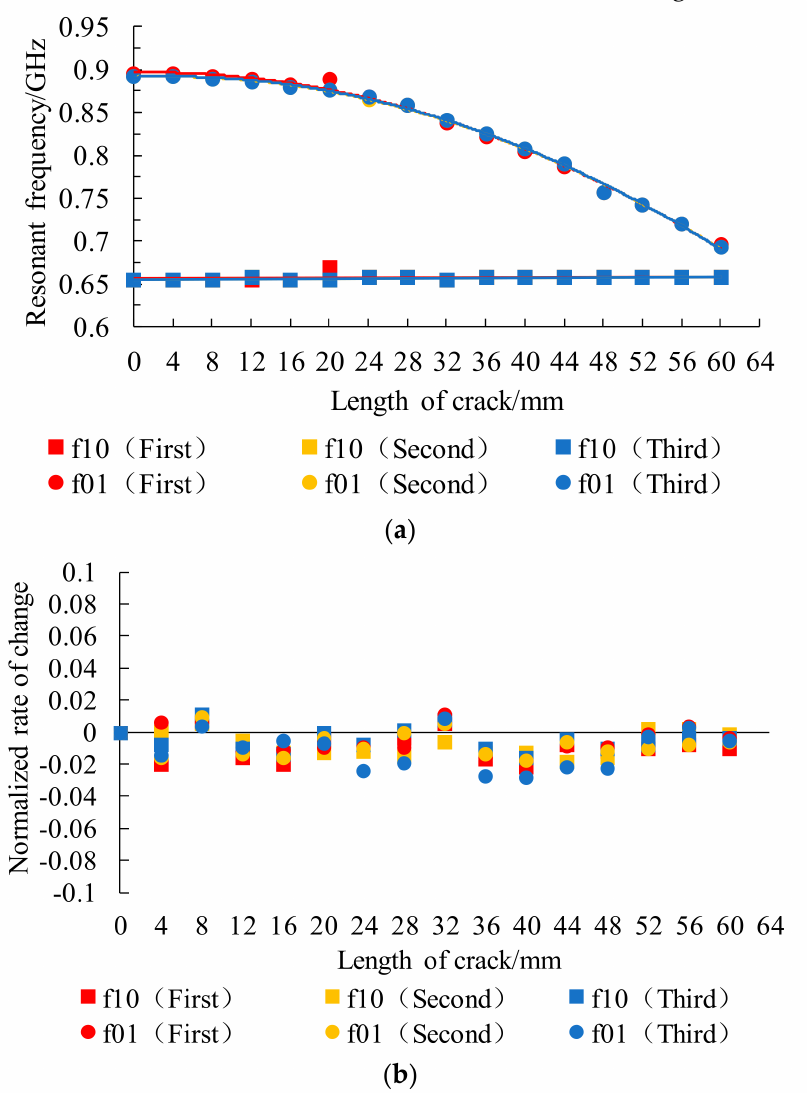
Figure 16. Resonant frequency changes of the multilayer patch antenna sensor during crack propa- gation: ( a ) resonant frequency of the underlying patch used for crack monitoring; ( b ) normalized rate of change of resonant frequency of the upper patch used for strain